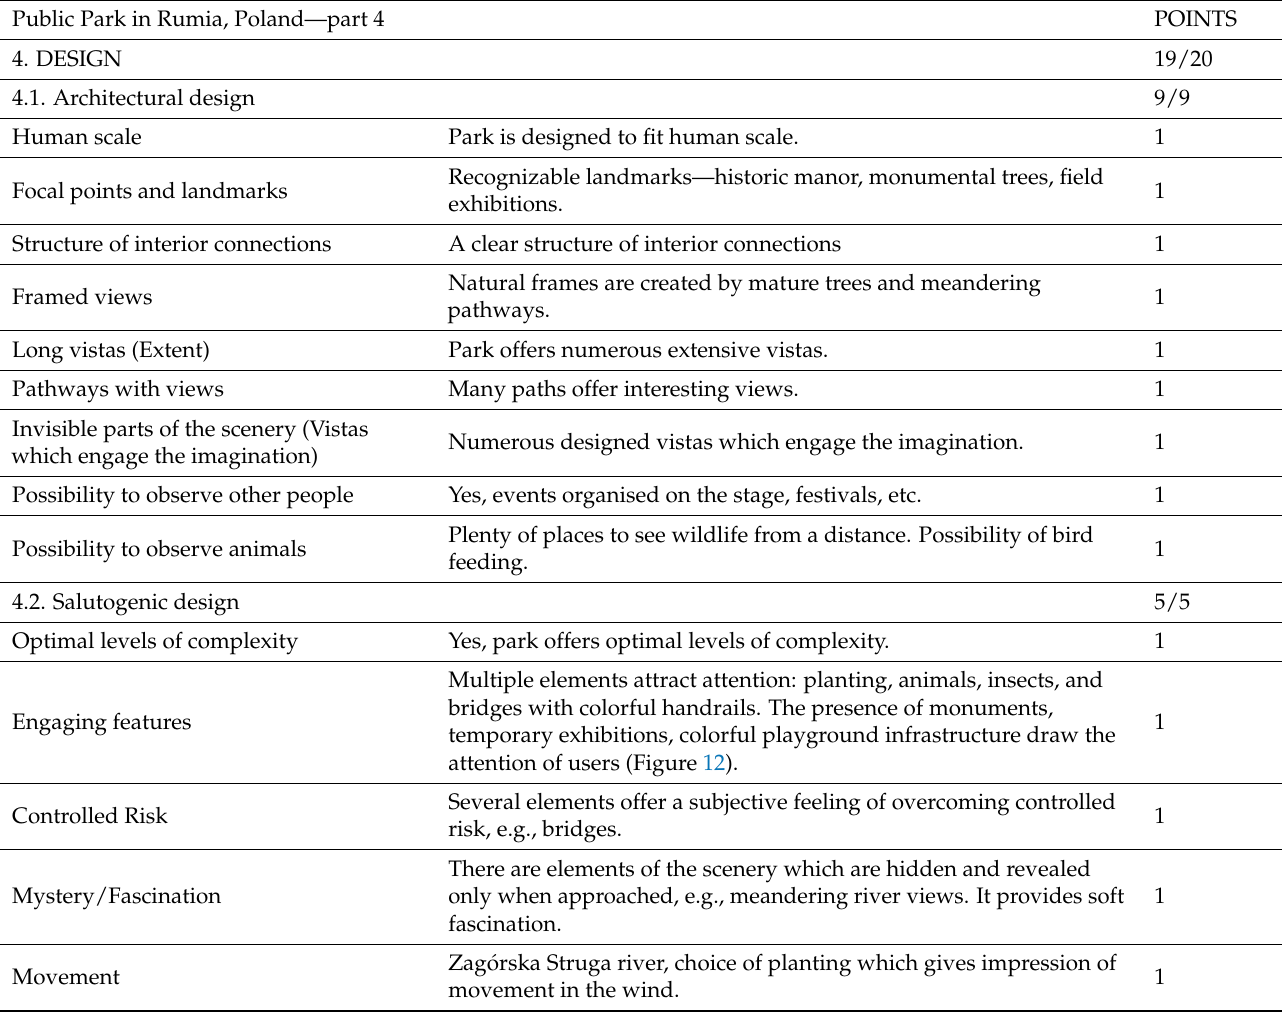
Table 4. Assessment of Public Park in Rumia, Poland—part 4, source: